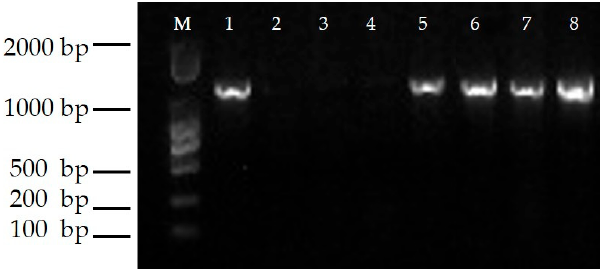
Figure 6. RT- PCR Analysis for the expression of CsTFL1a in transgenic lines, M: DL 2000 DNA Marker; 1: positive control, 2: WT, 3: double distilled (dd) H 2 O; 4–8: Transgenic resistant plants.